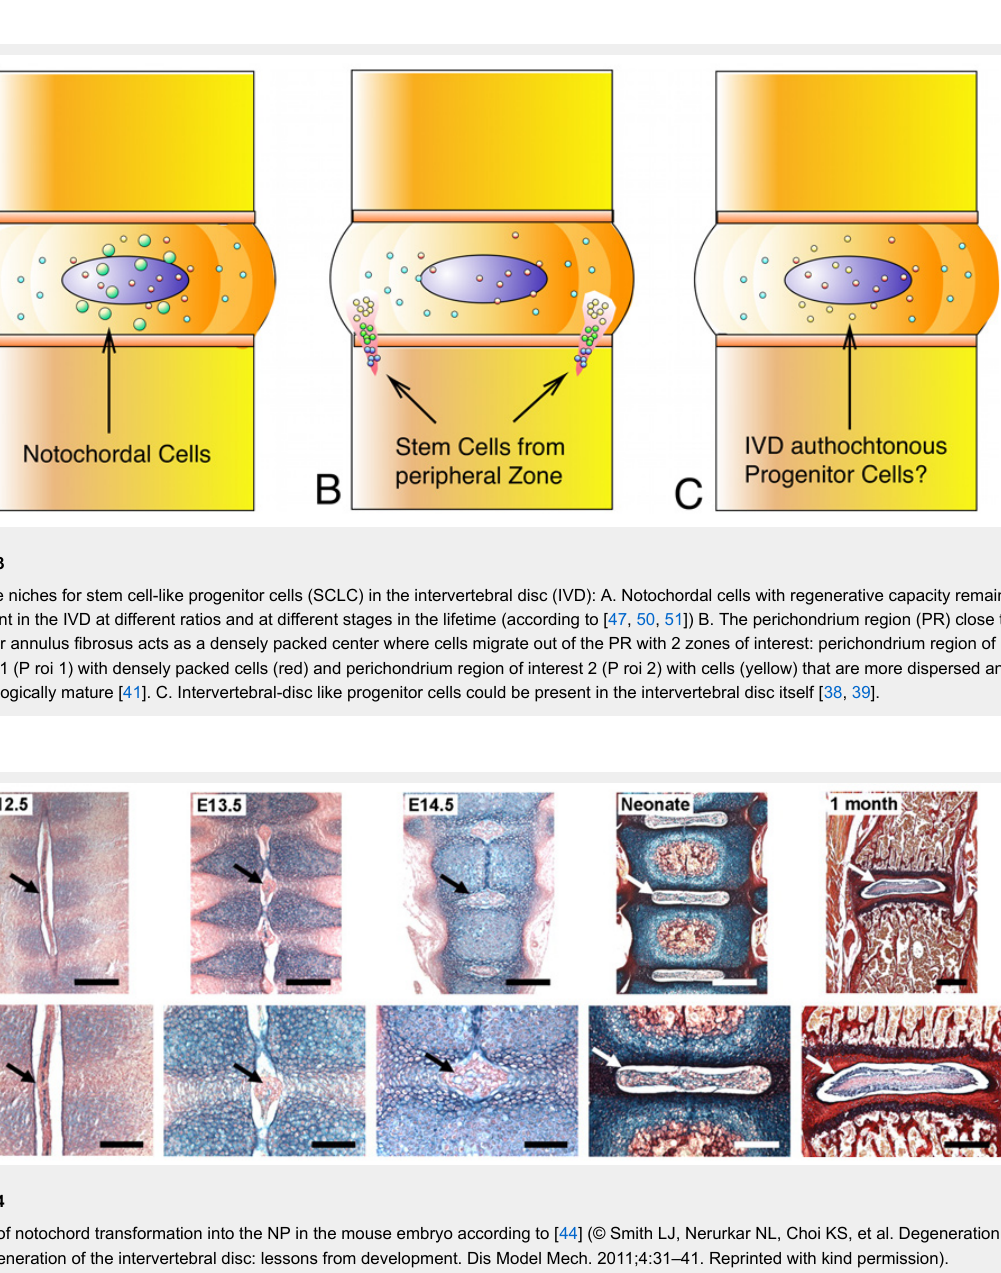
Stages of notochord transformation into the NP in the mouse embryo according to [44] (© Smith LJ, Nerurkar NL, Choi KS, et al. Degeneration and regeneration of the intervertebral disc: lessons from development. Dis Model Mech. 2011;4:31–41. Reprinted with kind permission). Embryos were stained with Alcian Blue (which marks glycosaminoglycans) and Picrosirius Red (which marks collagen). At embryonic day (E)12.5, the notochord (arrow) runs uninterrupted along the length of the vertebral column. Sclerotome cells have condensed perichordially, and metameric patterning of future disc and vertebral body condensations is apparent. At E13.5, the notochord has begun to contract within the vertebral body regions and expand within the disc regions (arrow). At E14.5, the notochord has virtually disappeared from the vertebral bodies, persisting solely in the locations of the future NPs (arrow). In the neonate, lateral expansion of the NP has occurred (arrow) and primary ossification centres are present in the vertebral bodies. At postnatal age 1 month, vertebral bodies are fully ossified and the NP (arrow) contains a glycosaminoglycan-rich extracellular matrix surrounded by the collagenous AF. Scale bars: E12.5, E13.5 and E14.5: 200 mm (top) and 100 mm (bottom); neonate: 400 mm (top) and 200 mm (bottom); 1 month: 500 mm (top) and 400 mm (bottom). Reprinted with permission from the publisher (Dis Model. Mech. 4, 31-41), available under a Creative Commons Attribution Non-Commercial Share-Alike License